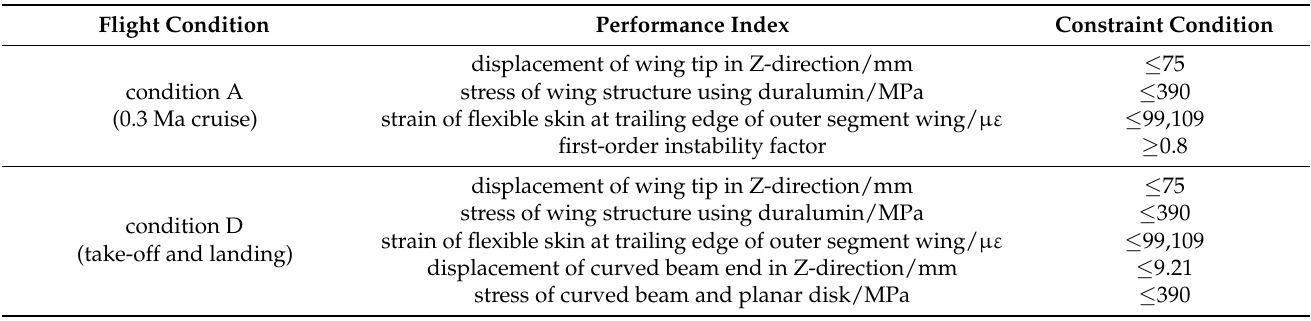
Table 5. Constraints of structure optimization.